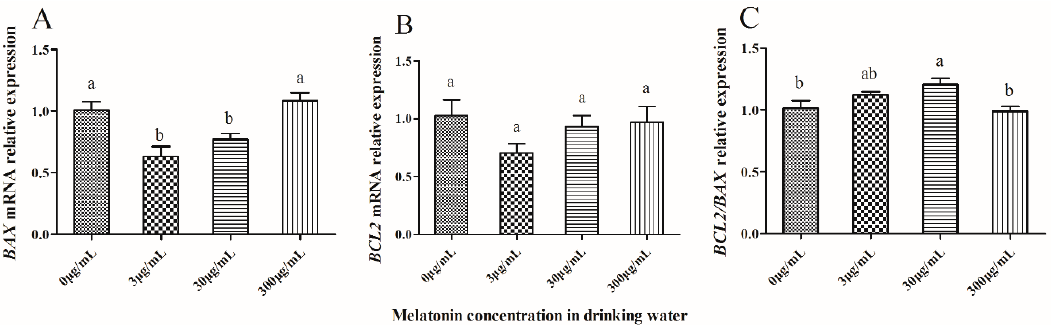
Figure 5. Effect of melatonin on gene expression of mRNA in mouse IVF-derived hatched blastocysts. BAX expression ( A ), BCL 2 expression ( B ) and BCL2/BAX relative expression ( C ) among all groups. The relative expression levels of mRNA were determined by the 2 −ΔΔ CT method and normalized against GAPDH. All data are the mean ± SD from 3 replicates. Different superscripts (a, b) represent treatment differences within panels ( p < 0.05).